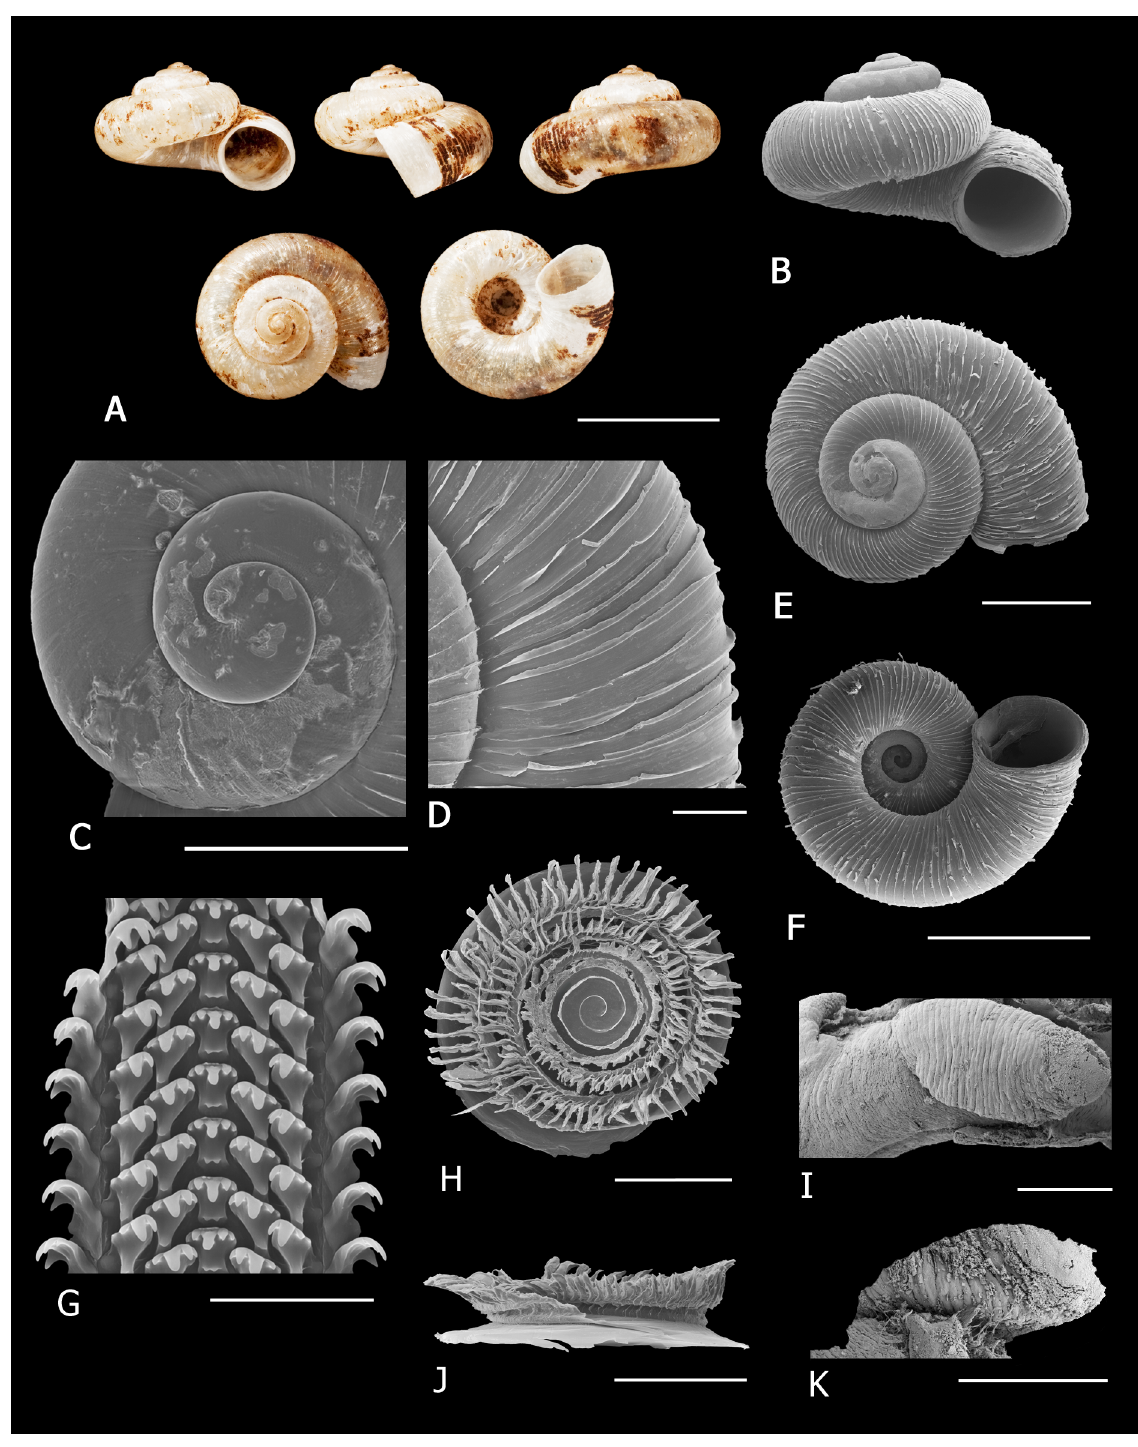
Fig. 33. Afrocyclus exsertus (Melvill & Ponsonby, 1903) gen. et comb. nov. A . Holotype (NHMUK 1904.4.29.28). B . Aperture view (ELM D16953). C . Protoconch (ELM D16951). D . Detail of axial lamellae of periostracum (ELM D16951). E . Dorsal view (ELM D16951). F . Ventral view (ELM W3654). G . Portion of radula (ELM W3654). H . Operculum (ELM W3654). I . Penis, dorsal view (ELM W3654). J . Operculum, lateral view (ELM W3655). K . Penis, lateral view (ELM W3654). Scale bars: A = 3 mm; B, E = 1 mm; C, H–K = 500 µm; D = 200 µm; F = 2 mm; G = 50